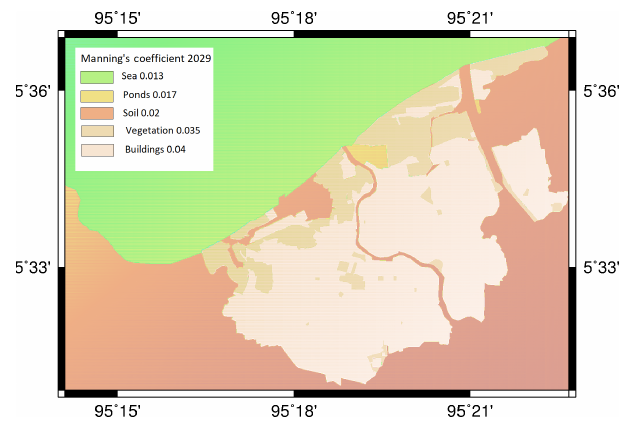
Figure 7. Distribution of Manning’s coefficients used in simulations for land use types as described in the Banda Aceh spatial planning regulation aimed to be implemented until